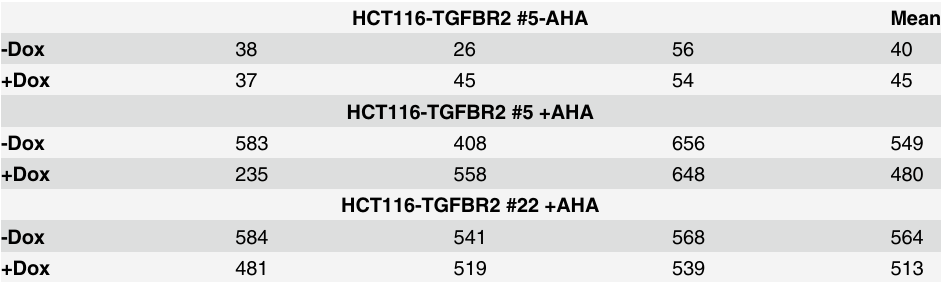
Table 1. Total number of proteins identified using mass spectrometric analysis.